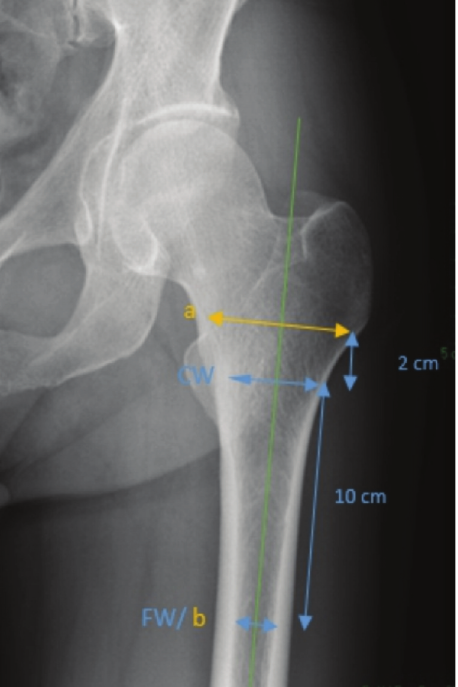
Anteroposterior post-operative radiograph of a right hip Fig. 2: showing determination of femoral stem subsidence and alignment of the femoral stem.